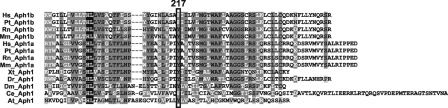
Alignment of vertebrate and invertebrate amino acid sequences of the region within APH1 surrounding residue 217.A black background indicates identical amino acid residues; a grey background indicates a conservative amino acid change. Abbreviations: Hs, Homo sapiens; Pt, Pan troglodytes; Rn, Rattus norvegicus; Mm, Mus musculus; Xt, Xenopus tropicalis; Dr, Danio rerio; Dm, Drosophila melanogaster; Ce, Caenorhabditis elegans; At, Arabidopsis thaliana. Sequences were aligned using Vector NTI (9.0) with default parameters.